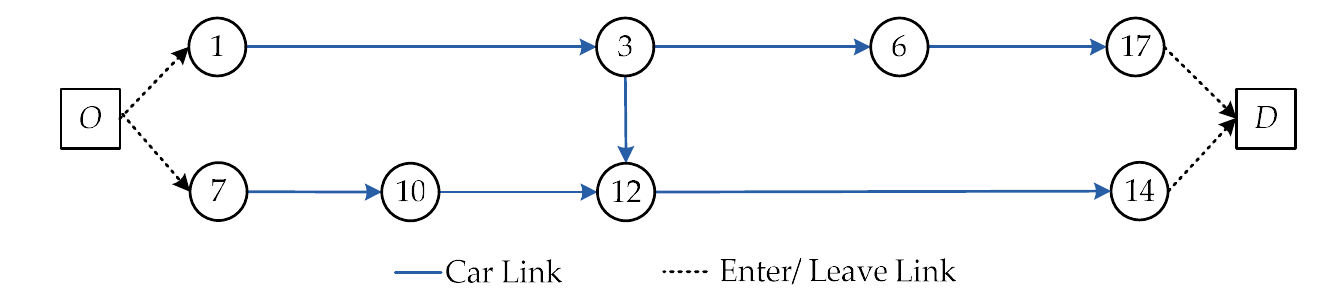
Figure 8. The car super network topology.